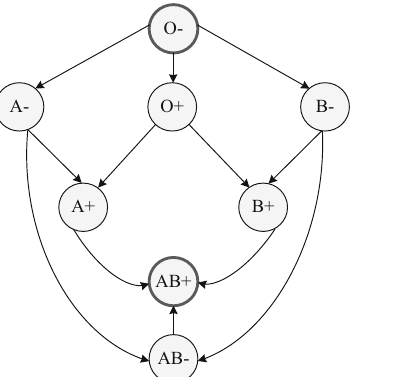
Fig. 1 ABO/ Rh (D)-compatible blood substitution graph of red blood cell (RBC)